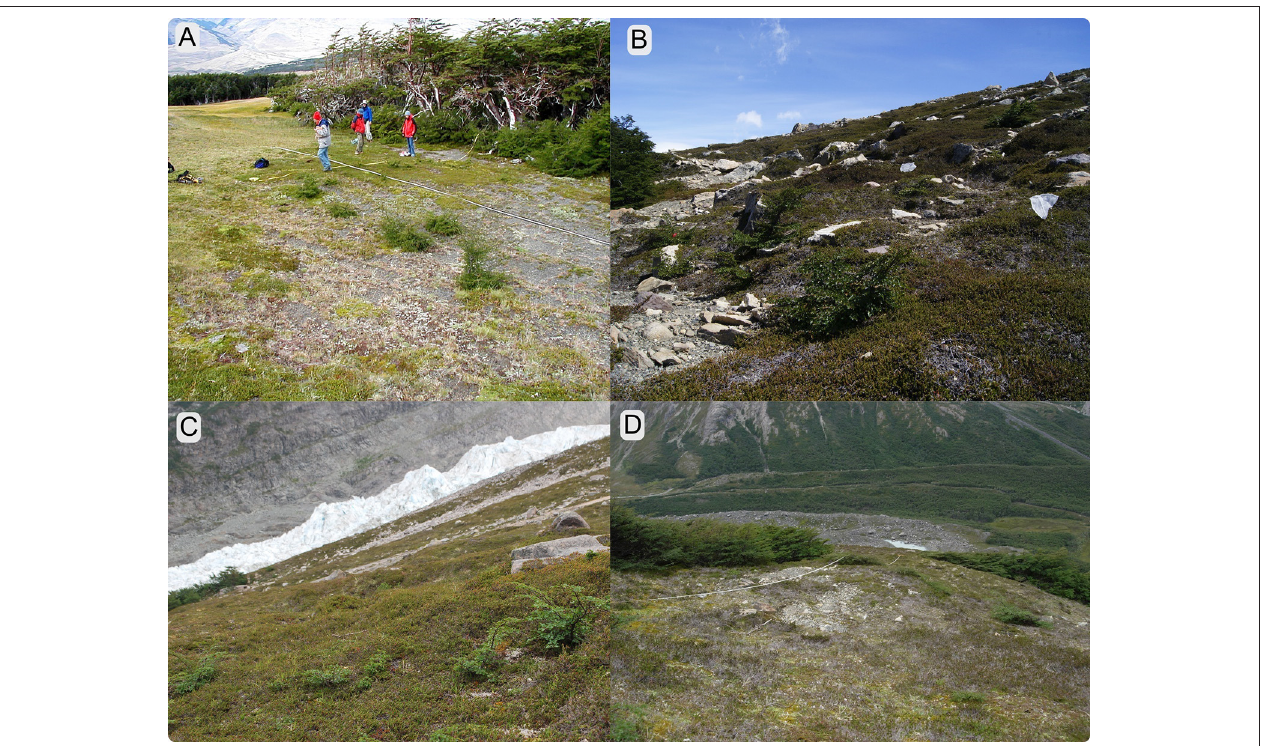
FIGURE 3 | Tree establishment above the Nothofagus abrupt treelines at the sampling sites. (A) El Chalten, (B) Estancia Los Huemules, (C) Glaciar Huemul, and (D) Estancia Rio